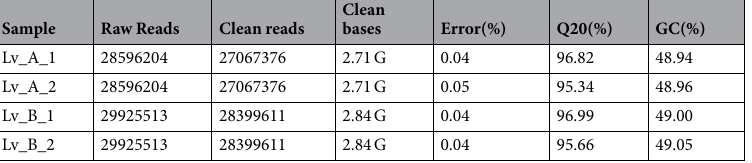
Table 1. Summary of transcriptome sequencing from L. vannamei . 1 means left reads, 2 means right